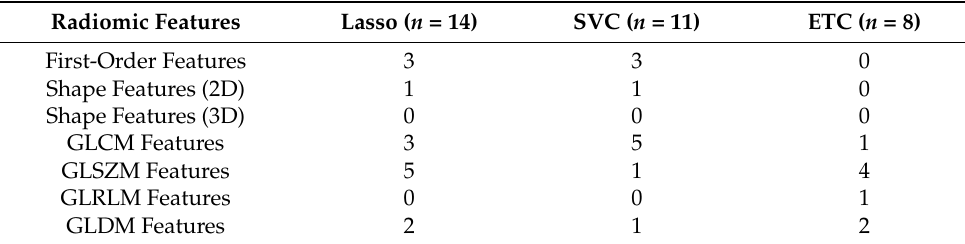
Table 3. The number of features selected by different feature selection methods.